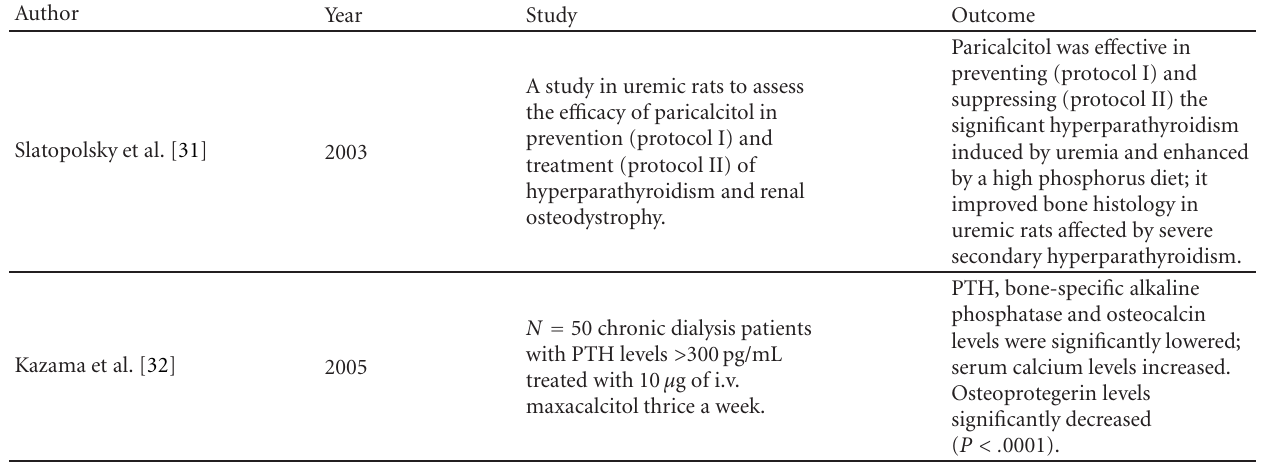
Table 6: Mineral metabolism and bone